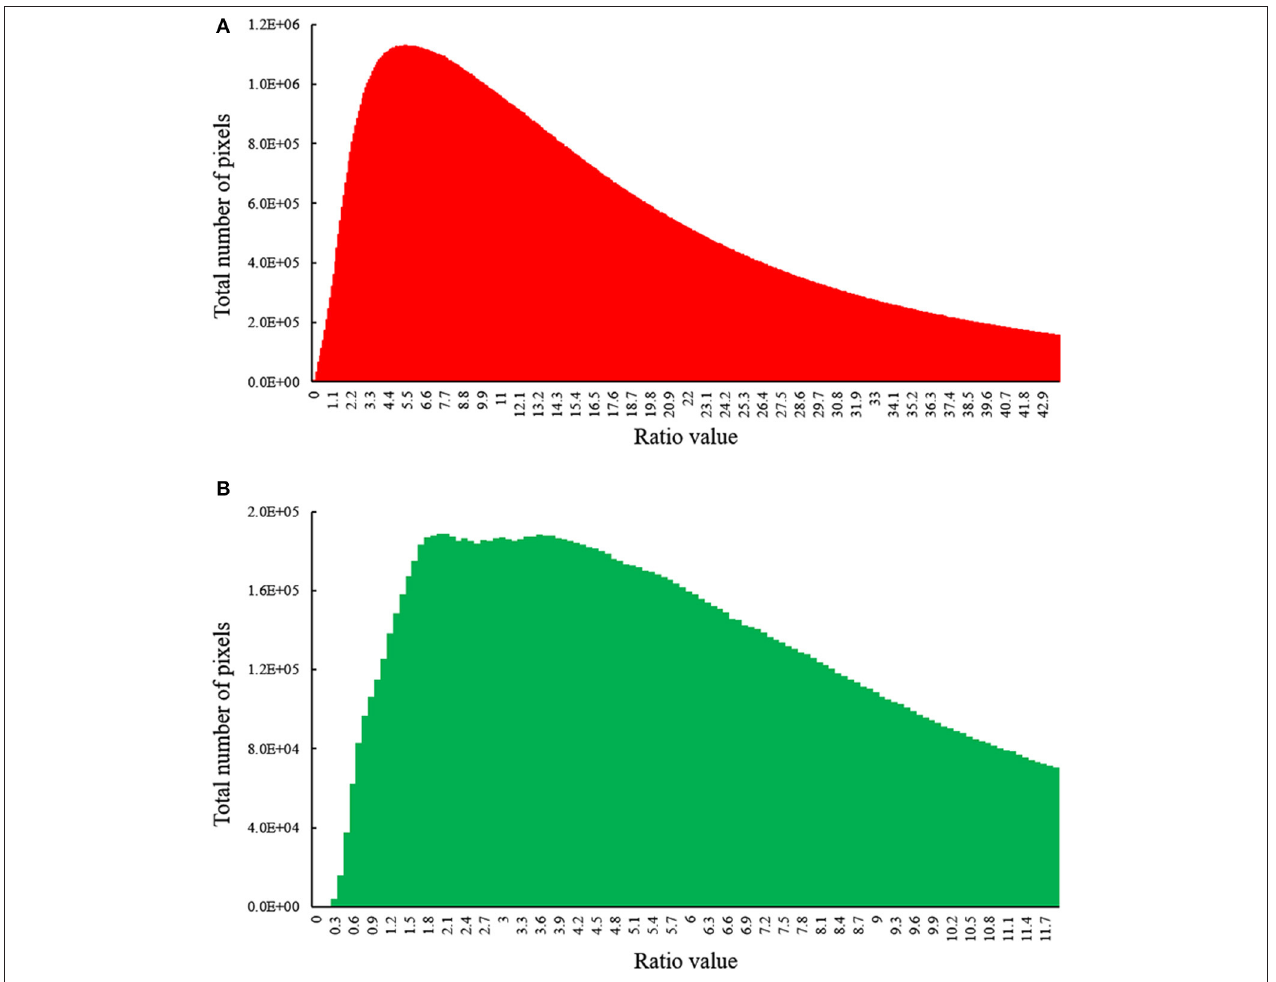
FIGURE 3 | Histogram of ratio values between the fluorescence image (F strobes ) to the ambient image (I ambient ) in (A) red channel (chlorophyll) and (B) green channel (GFP) for all image pairs photographed during our survey ( n = 275). The fluorescence is mostly in the order of the ambient light or higher, resulting in high signal-to-noise-ratio in the subtracted images. Histograms depict fluorescent pixels